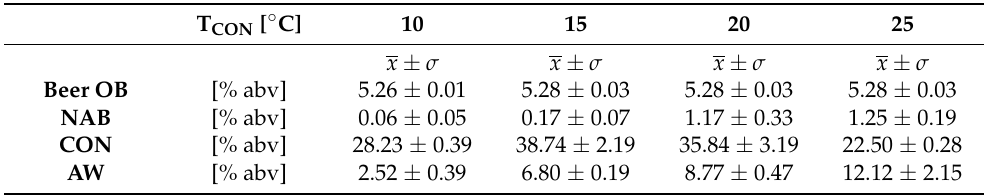
Table 1. Ethanol concentration ( x ± σ ) in the original product (beer OB) and in the products obtained after the thermal dealcoholisation process: non-alcoholic beer (NAB), condensate (CON) and the fluid of the aroma recovery ‘aromawater’ (AW). The process was performed at different values for the condenser temperature (T CON ).